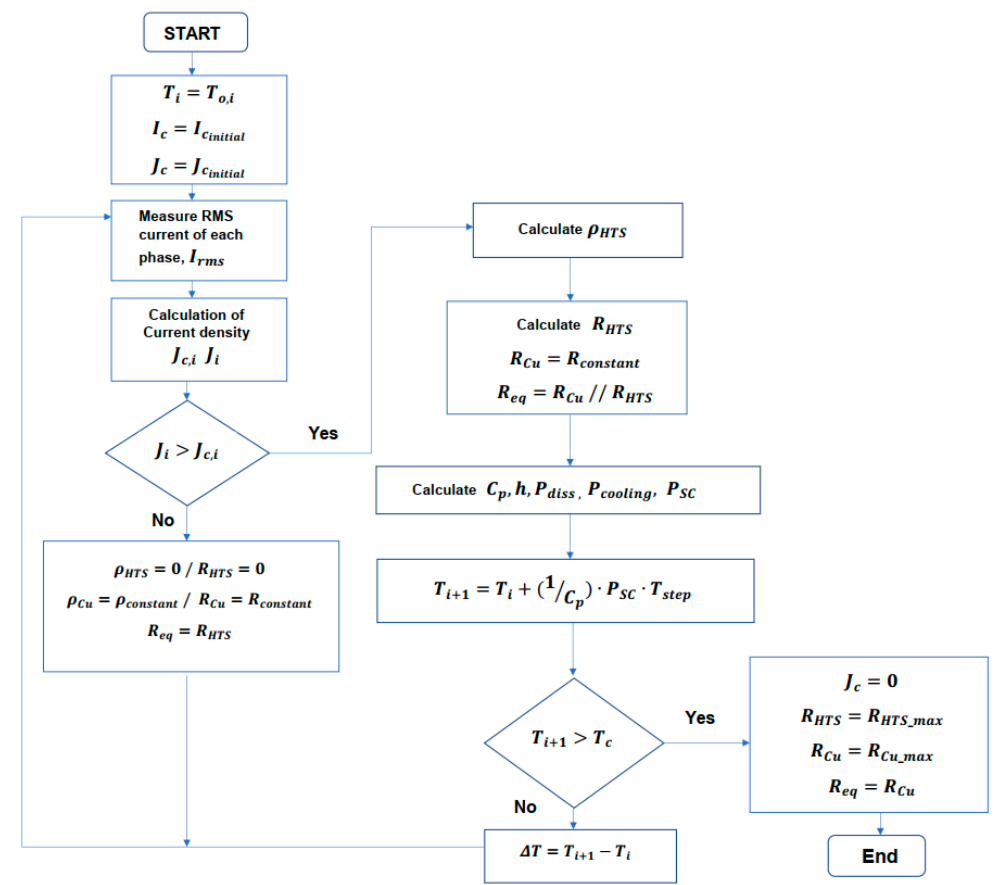
Figure 5. Flowchart corresponding to the calculation process for the resistance values of the HTS tapes R HTS , the copper stabilizer R Cu , the equivalent R eq , and the variation of the temperature ∆ T of the superconductor.